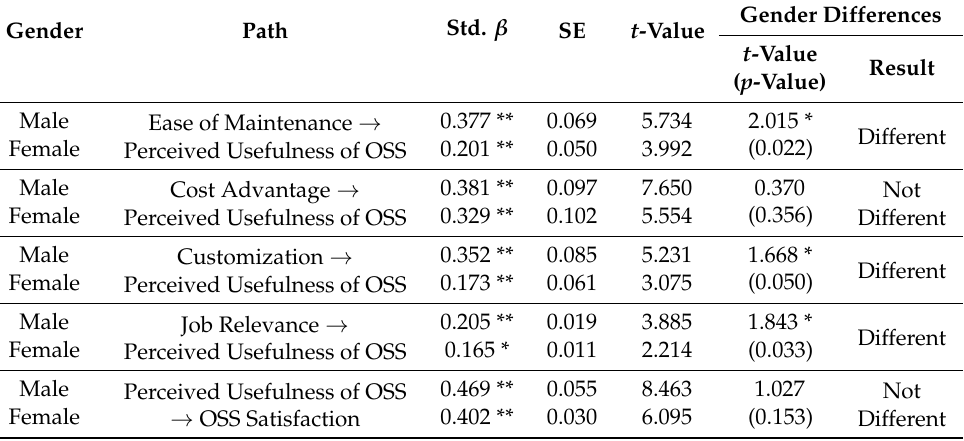
Table 9. Path differences between male and female